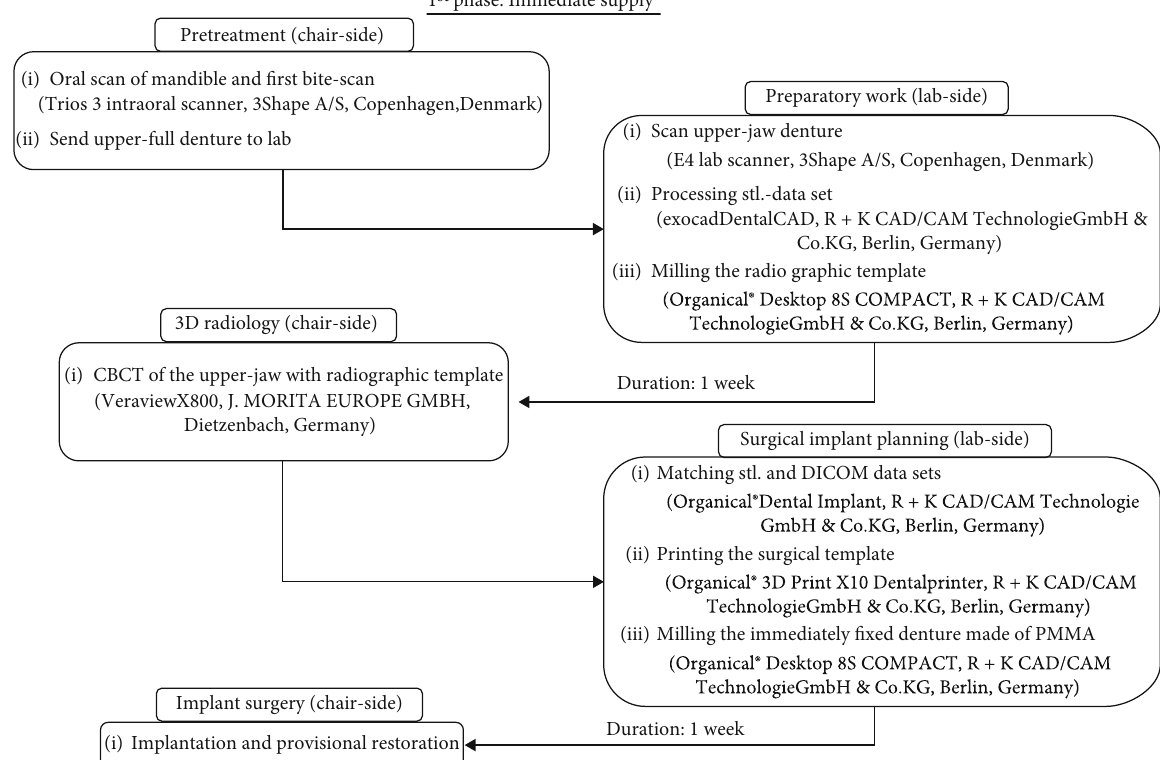
Figure 1: Overview of the 1 st treatment